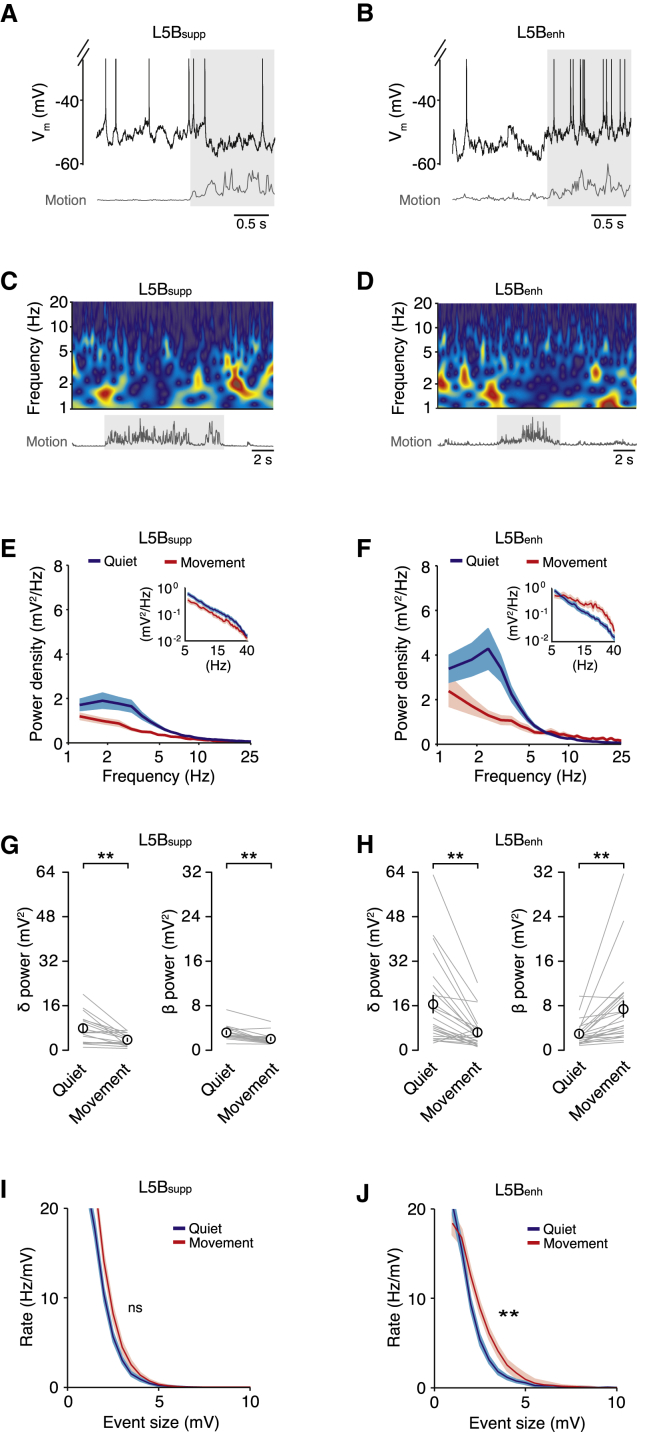
Movement Reduces Slow, Large-Amplitude Vm Fluctuations but Increases Excitatory Drive in L5Benh Neurons(A and B) Representative high-time resolution voltage traces for L5Bsupp (A) and L5Benh (B) neurons during quiet wakefulness and movement (gray shading).(C and D) Low-time resolution wavelet spectrograms for L5Bsupp (C) and L5Benh (D) neurons during quiet wakefulness and movement. Representative examples correspond to neurons shown in (A and B).(E and F) Average Vm power density for L5Bsupp (E, n = 17) and L5Benh (F, n = 24) pyramidal neurons during quiet wakefulness (blue) and movement (red). Data represent mean ± SD. Insets show average Vm power density between 5 and 40 Hz.(G and H) Average Vm power in δ (1.5–4 Hz) and β (12–30 Hz) frequency bands in L5Bsupp (G, n = 17) and L5Benh (H, n = 24) pyramidal neurons during quiet wakefulness and movement. Gray lines represent data from individual neurons and black symbols represent mean ± SEM. ∗∗p < 0.01.(I and J) Average rate density of compound synaptic events in L5Bsupp (I, n = 17) and L5Benh (J, n = 24) pyramidal neurons during quiet wakefulness (blue) and movement (red). Data represent mean ± SD. ∗∗p < 0.01; ns, non-significant.See also Figure S2.